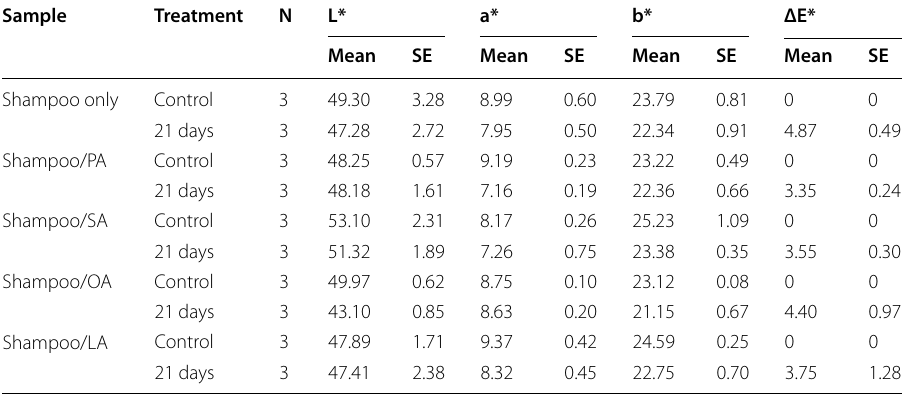
Table 12 Color values of bleached hair after shampoo with or without the use of hair conditioner containing four types of fatty acids Sample